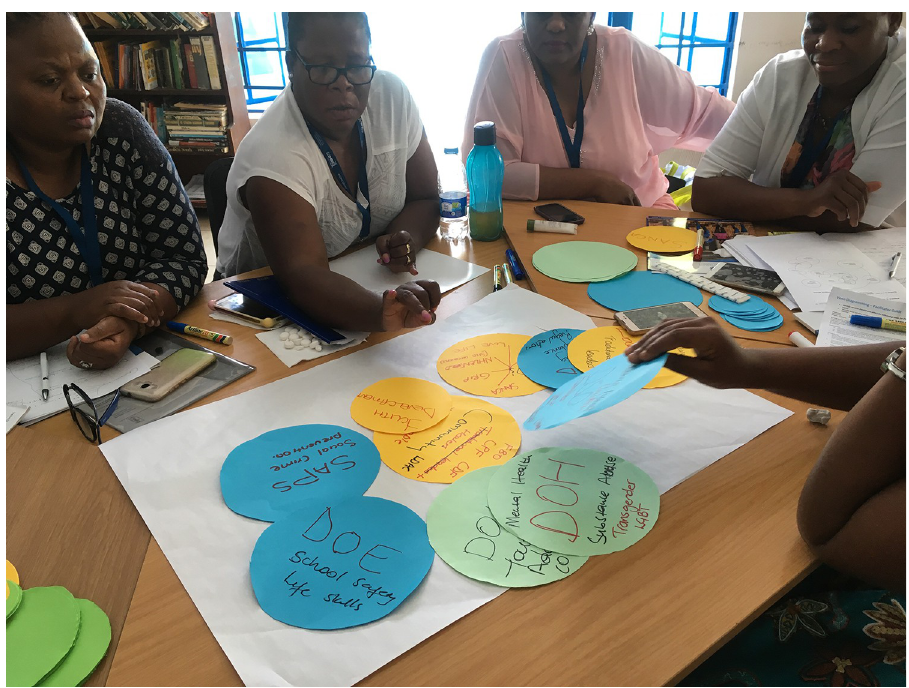
Fig 4. Government, non-government and community stakeholders map key actors and institutional contexts to address issues identified. Image owned by the VAPAR programme and reproduced with permission in this paper under a creative commons license. Permissions have been secured from participants for the reproduction of all images taken during the course of the research.